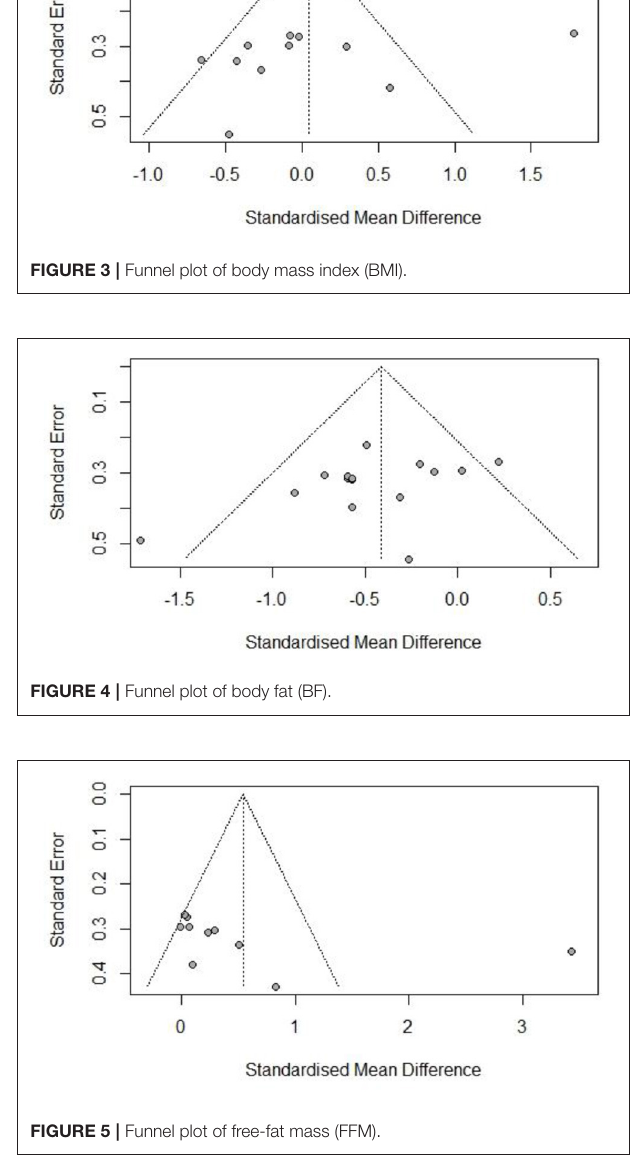
regression did not reach statistical significance (Egger test for BMI, p = 0.28; Egger test for BF, p = 0.09; Egger test for FFM, p = 0.21).